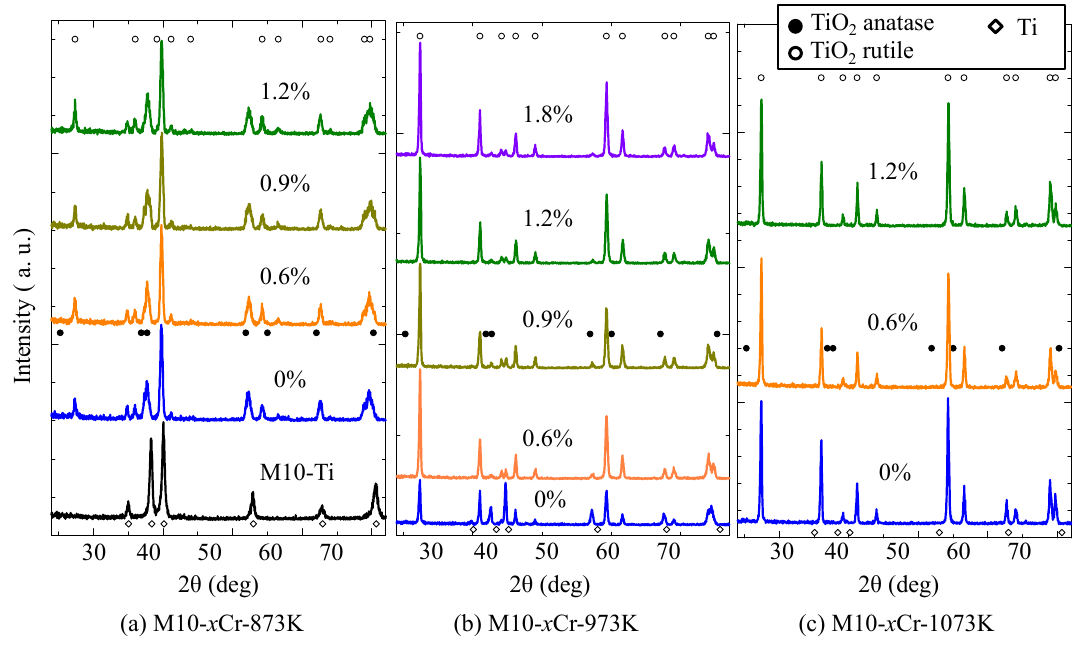
Figure 49. XRD patterns of the M10- x Cr- y K